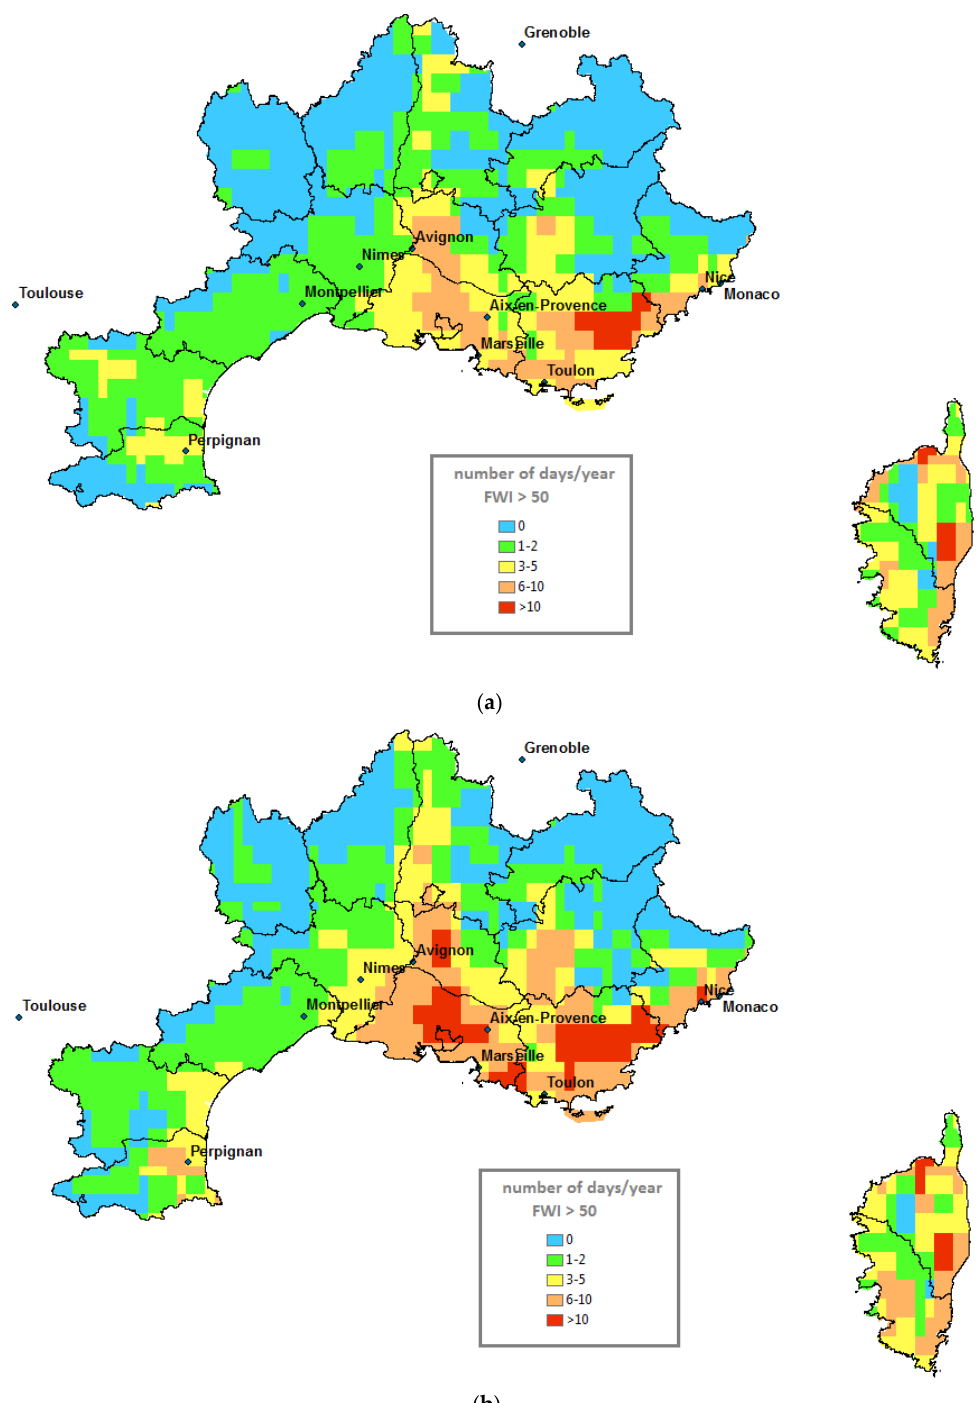
Figure 7. ( a ) Climatic model MPI/RCP8.5/number of days/year Fire Weather Index (FWI) > 50: period: 2006 – 2015; ( b ) Climatic model MPI/RCP8.5/number of days/year FWI > 50: period: 2036 – 2045.